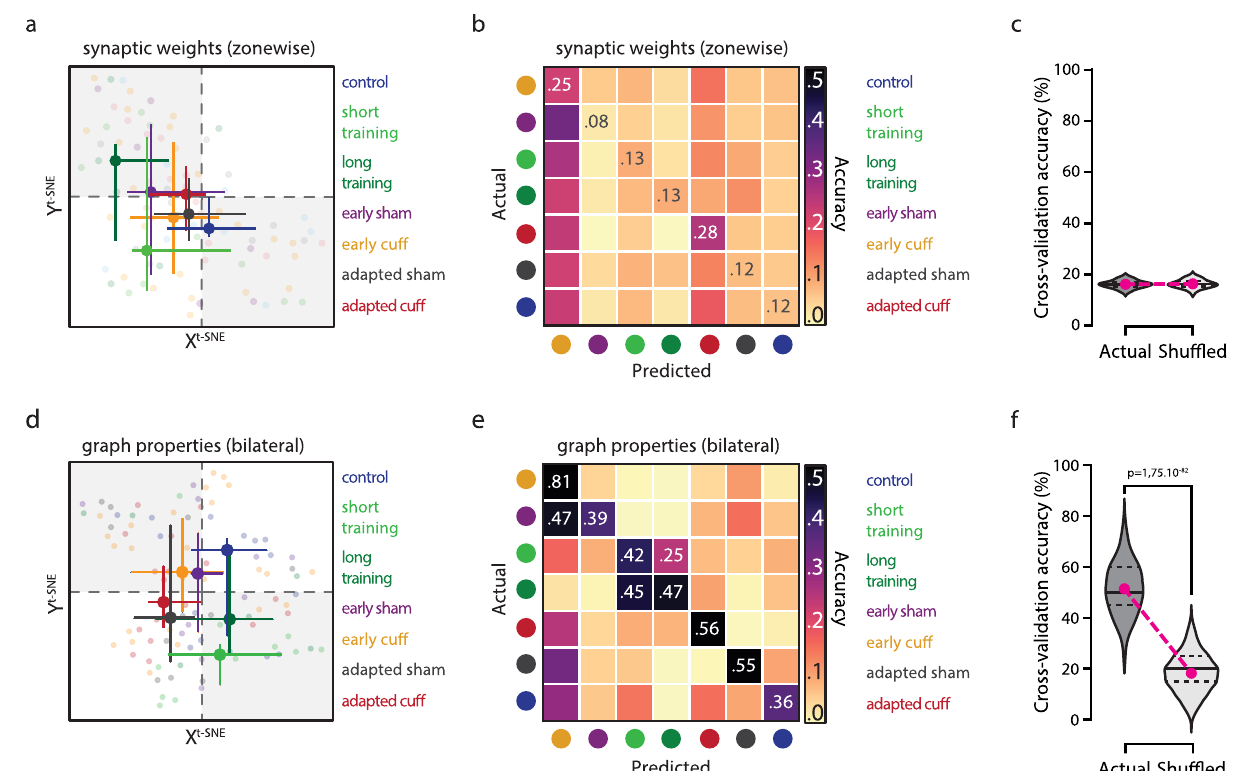
Fig. 5 Graph features can predict locomotor conditions. a Dimensionally-reduced representation of synaptic connectivity maps, described in terms of averaged synaptic weights. Individual synaptic maps were parameterized as an eight-dimensional vector with entries given by the normalized, average synaptic weight in each microzone (Supplementary Fig. 1). These vectors were visualized in a 2D space via t-SNE, a non-linear dimensional reduction algorithm. Individual dots represent the position of each map in the projection space. Dots are colored according to the groups. Bigger dots represent the median of map positions for each group, and error bars the dispersion (interquartile range). n (maps/mice) control, 14/9; short training, 13/7; long training, 11/6; early sham, 11/7; early cuff, 25/13; adapted sham, 14/9; adapted cuff, 17/8. b Classi fi cation of synaptic maps based on synaptic weights. Map vectors described in a were maps used to train a supervised random forest classi fi er ( n trial = 100). Accuracy of classi fi cation is displayed via a confusion matrix, the entries of which provide probabilities of correct classi fi cation (diagonal entries) or of misclassi fi cation (off-diagonal entries). c Average global accuracy of the trials performed with the random forest classi fi er shown in b for actual and shuf fl ed labels (i.e., chance-level). Mean ± SD; 0.161 ± 0.01, n (actual) = 100; 0.163 ± 0.01, n (shuf fl e) = 100. Magenta dot, average; dashed-black line, interquartile range; solid black line, median. d Alternative t-SNE projection of synaptic maps reparametrized using graph properties (i.e., modularity index, ipsi- and contralateral assortativity, module degree z -score and participation coef fi cient; n (maps/mice) same as above . e Classi fi cation of synaptic maps based on bilateral graph properties using a random forest classi fi er ( n trial = 100). Same representation as in b. f Average global accuracy of the trials performed with the random forest classi fi er shown in e for actual and shuf fl ed labels (i.e., chance-level). Mean ± SD; 0.51 ± 0.1, n (actual) = 100; 0.18 ± 0.07, n (shuf fl e) = 100. Two-tailed MWU, p -value in graph. Magenta dot, average; dashed-black line, interquartile range; solid black line, median. Source data are provided as a Source Data fi Fig. 6a. Being now interested in individual-level differences, superimposed trend lines, a correlation seems to hold between beyond group-level differences, we fi tted jointly a GLM on all the actual and predicted values, at the level of the pooled group, and individuals for which each given target behavioral feature had sometimes even stronger when restricted to subgroups (Fig. 6c). been measured. We thus pooled prior to GLM fi tting: the short We used two performance metrics to quantify the cross-validated training and the long training groups, for both of which we performance of generalization prediction and avoid over fi tting measured slope and total distance in the wheel training (Fig. 3a); (i.e., prediction performed by models on data points for which they were not trained on, see Methods section): the Pearson correlation between actual and GLM-predicted values ( R -value; top right insets of Fig. 6b, c); and the Mean Square Error of prediction (MSE; bottom right insets of Fig. 6b, c). Both these metrics were evaluated over the whole pooled short and long training groups or separately over the two groups. For the larger pooled dataset, both metrics were signi fi cantly better than chance expectations. R -values for pooled data reached 0.81 ± 0.04 (actual) vs 0.02 ± 0.08 (shuf fl ed, Fig. 6c) for total distance and